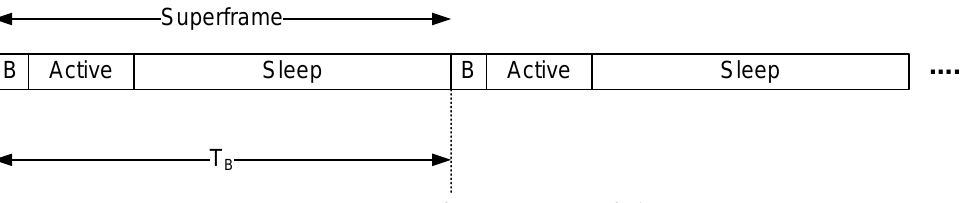
Figure 2. Basic Superframe structure of ThMAC.